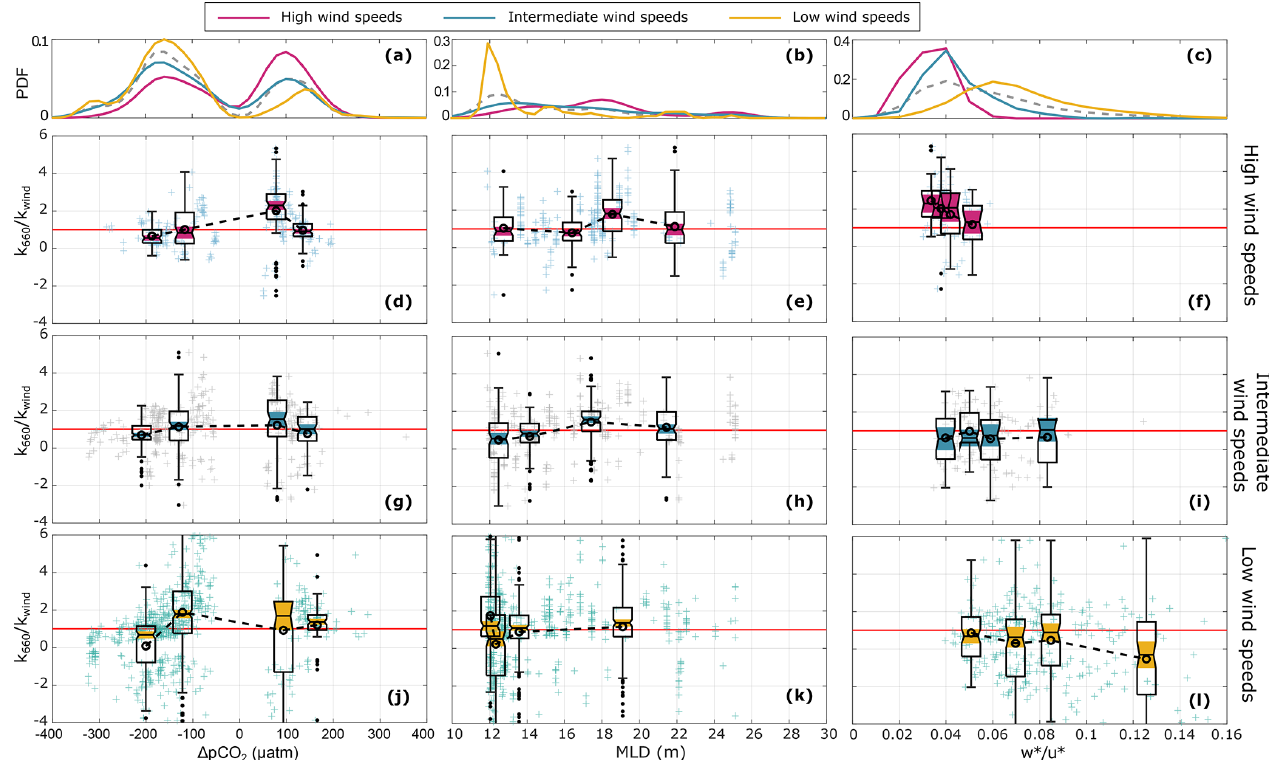
Figure A1. Water-side control mechanisms: (cid:49)p CO 2 (left), mixed-layer depth (centre), and water-side convective scale normalized with the friction velocity ( w ∗ /u ∗ ) (right). Top panels (a) , (b) , and (c) show the probability distribution function (PDF). Panels (d) to (l) show the normalized gas transfer velocity ( k 660 /k wind ) under high (upper), intermediate (middle), and low (lower) wind speeds. The crosses represent the individual half-hourly values. The boxplots give a statistical summary for equidensity bins defined based on the distribution of k 660 /k wind as a function of each of the parameters. The median, first, and third quartiles are represented in each box; the whiskers represent the minimum and maximum values, and the black dots represent the outliers; the notches highlighted in yellow indicate the median’s 95% confidence interval. The open circles linked with a dashed line indicate the bin means, and the horizontal red line indicates k 660 /k wind =